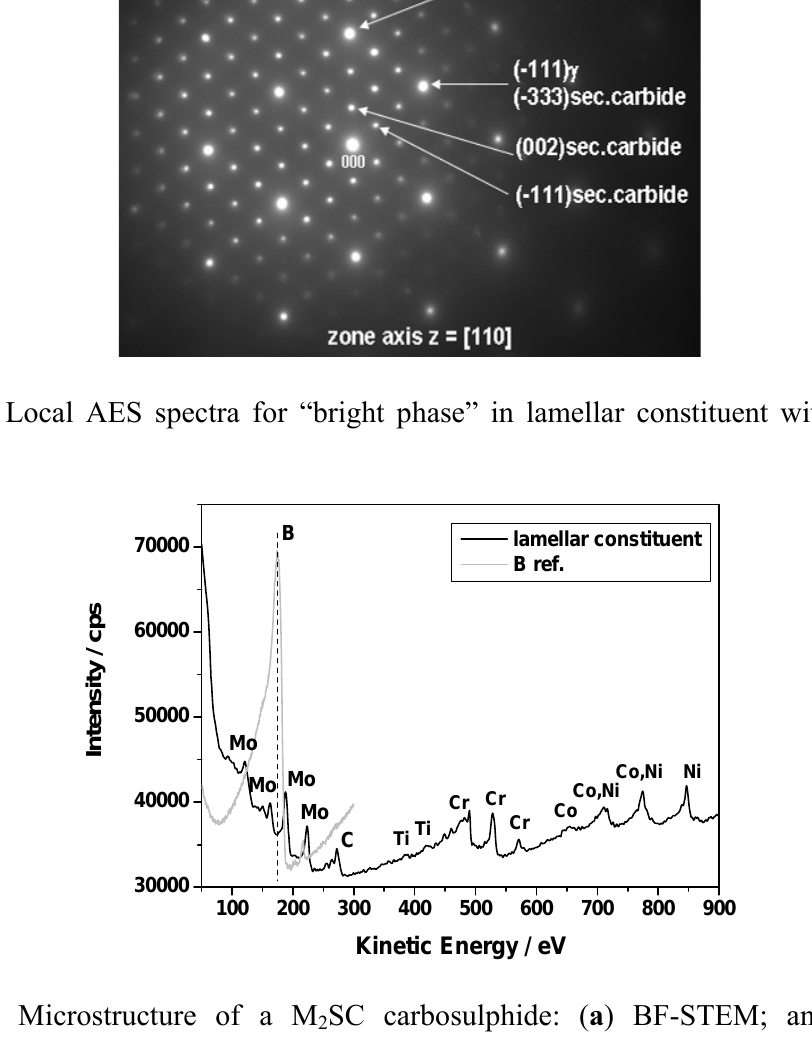
SC carbosulphide: ( a ) BF-STEM; and ( b ) high 2